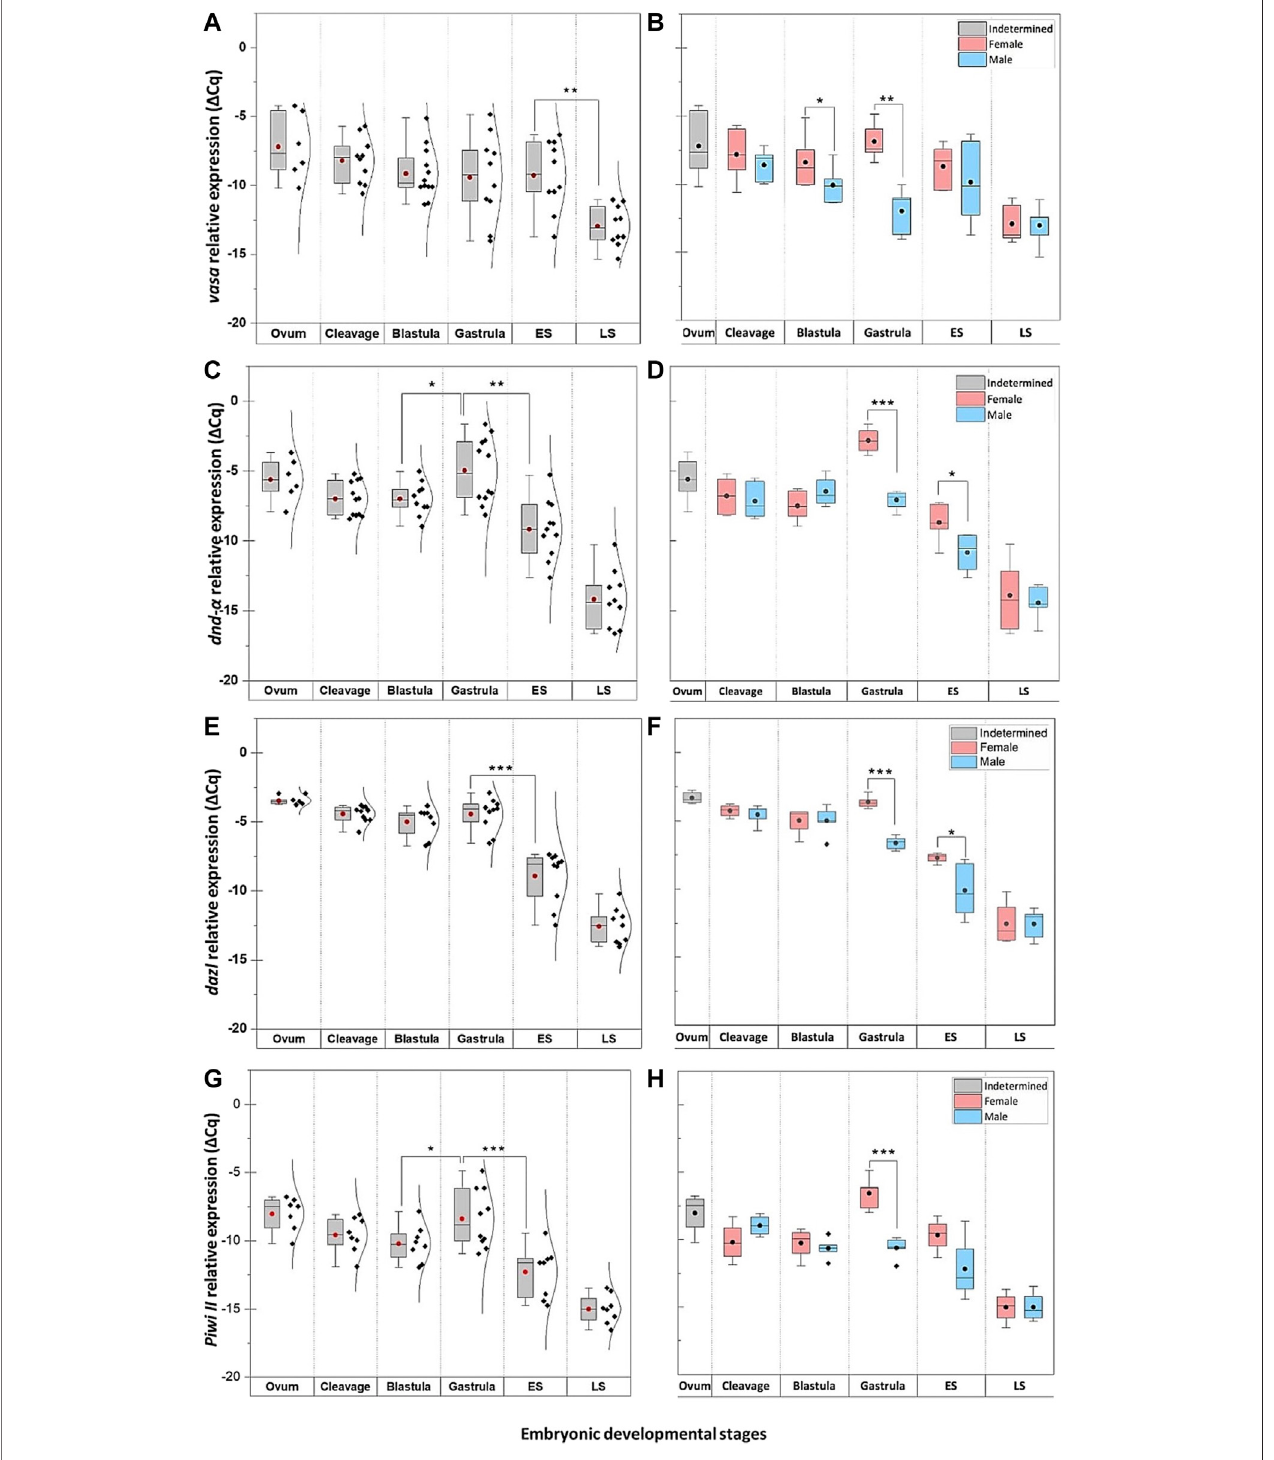
FIGURE 5 | The temporal expression of PGC markers at select embryonic stages of G. holbrooki . The pooled (left panel) and sex-segregated (right panel) quantitativeexpressionof vasa (A – B) , dnd- α (C – D) ), dazl (E – F) ,and piwiII (G – H) insixembryonicdevelopmentalstagesof G.holbrooki .ES,earlysomitogenesis;LS,late somitogenesis. The dots and the horizontal line within the bars indicate mean and median of the data presented within the groups. The normal distribution curves are given in the pooled expression plots. The asterisks show the level of signi fi cance between groups; Tuckey ’ s HSD, * (cid:1) 0.05, ** (cid:1) 0.01, *** (cid:1) 0.001.